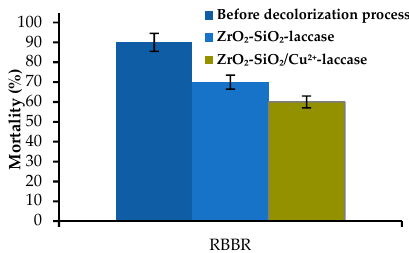
Figure 11. Mortality of Artemia salina in the solution before and after enzymatic treatment.